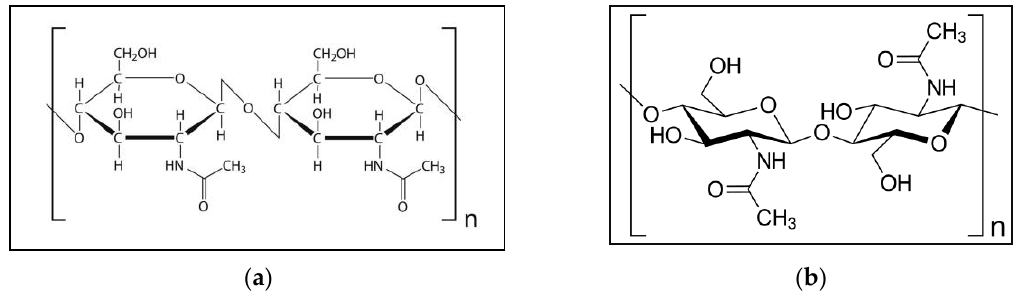
Figure 1. ( a ) Chemical configuration of chitin; ( b ) structure of the chitin molecule, showing two of the N-acetylglucosamine units that repeat to form long chains in the β -(1 → 4)-linkage.